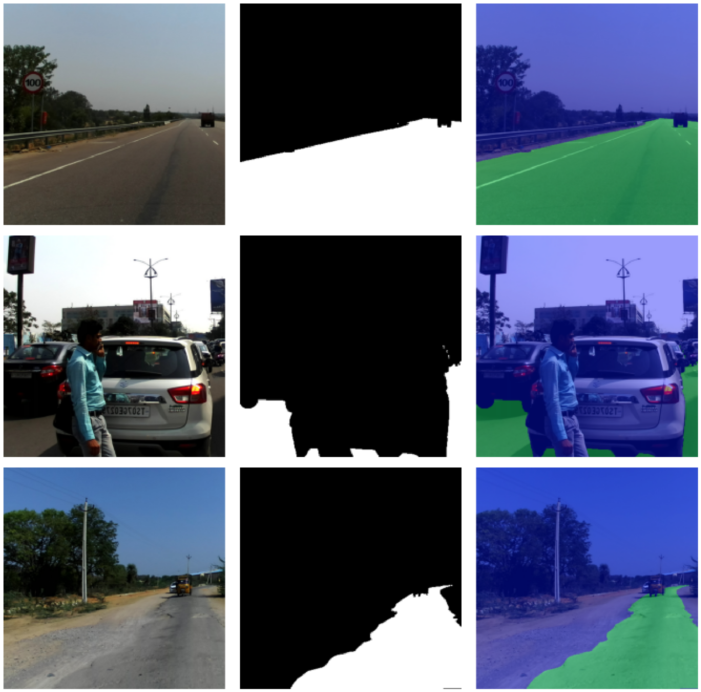
Figure 1. Preprocessed samples of the Indian Driving Dataset (IDD) [4], which depict unstructured urban environments where streets are not well delineated and pedestrians or drivers rarely stick to the rules. The centre and right columns show the ground truth segmentation masks per